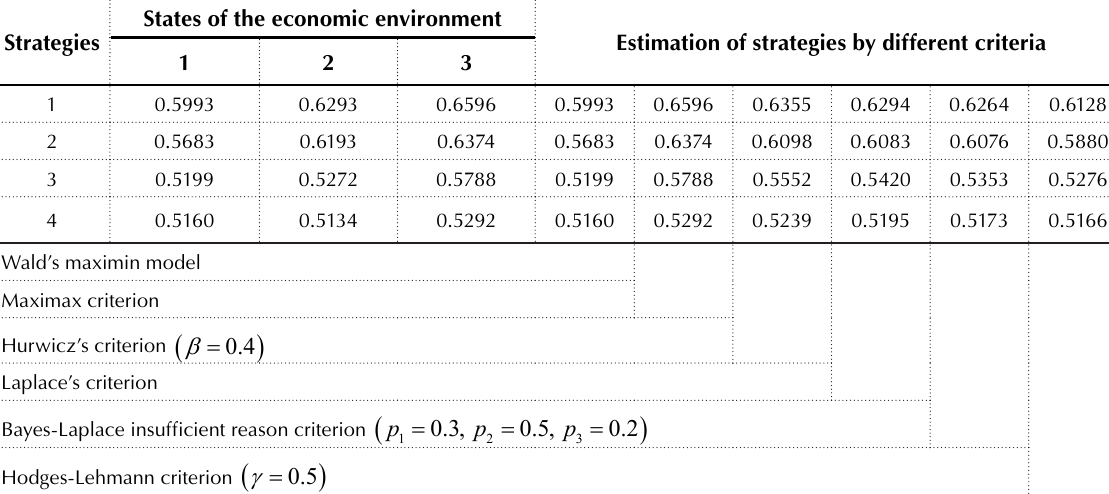
Source: Own calculations.